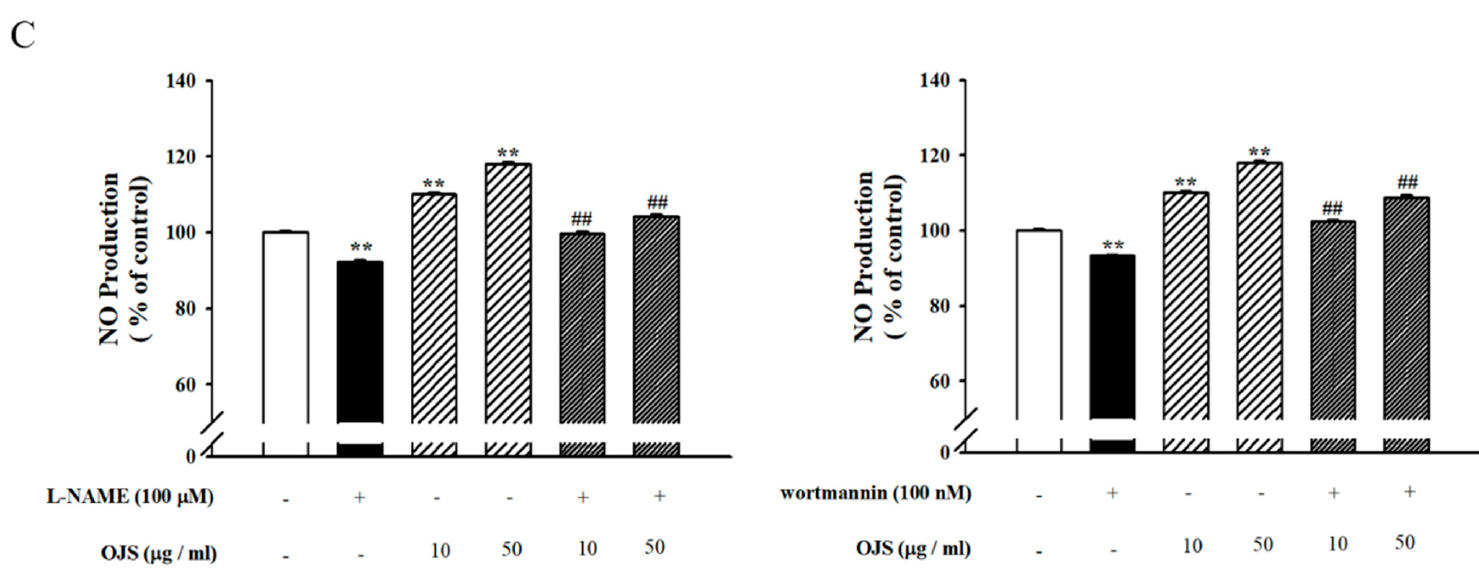
Figure 8. Effects of OJS on nitrite production. Protein expression of phosphorylated endothelial nitric oxide synthase (eNOS), phosphorylated protein kinase B (Akt), and GTP cyclohydrolase-1 (GTPCH) were analyzed by Western blotting ( A ). NO production was examined via fluorescence microscopy (original magnification ×100) ( B ). The effect of OJS on NO production was assayed as its stable reaction product nitrite by using the Griess reaction ( C ). Data are presented as means ± S.E. ** p < 0.01 vs. control, ## p < 0.01 vs. OJS treatment. L -NAME, N(G)-nitro- L -arginine methyl ester.